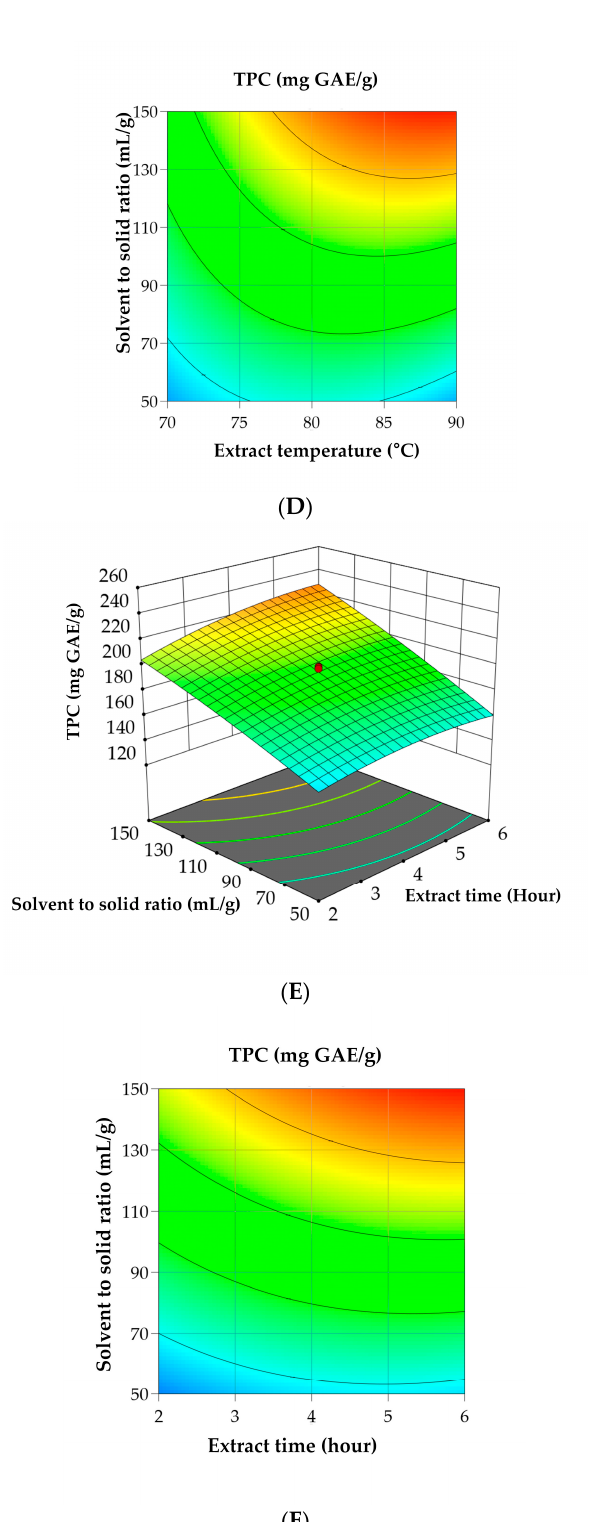
Figure 3. Response surface and contour plots exhibit the effect of hydrothermal extraction temper- ature, time, and solvent-to-solid ratio on the total phenolic contents (TPC) from Acer tegmentosum . ( A/B ) Effect of extraction temperature and extraction time on the TPC as ( A ) a 3D response surface graph and ( B ) a contour plot. ( C/D ) Effect of extraction temperature and solvent-to-solid ratio on the TPC as ( C ) a 3D response surface graph and ( D ) a contour plot. ( E/F ) Effect of extraction time and solvent-to-solid ratio on the TPC as ( E ) a 3D response surface graph and ( F ) a contour